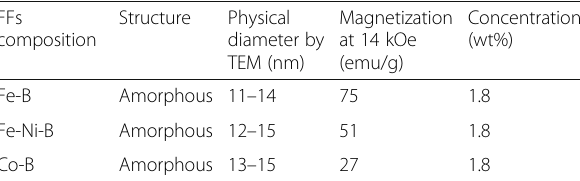
Table 1 The structure, size, magnetization, and concentration of different FF samples